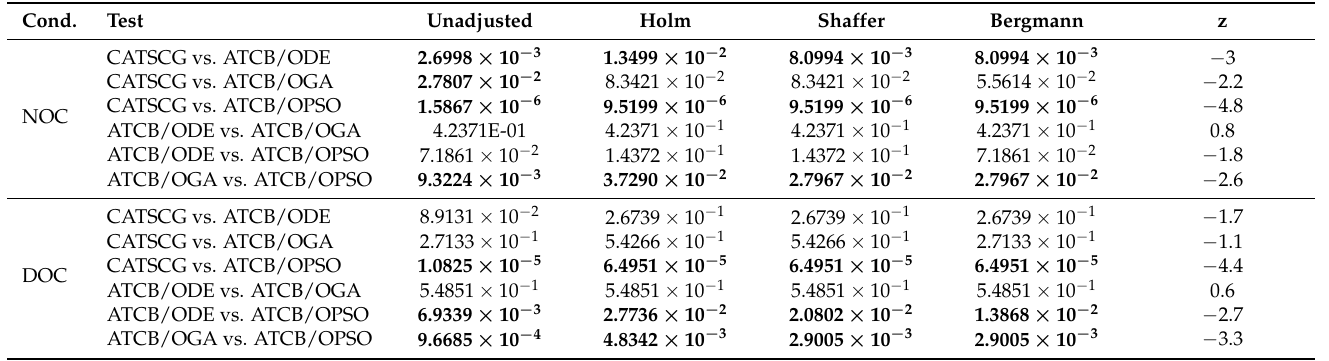
Table 8. Results of the post hoc Friedman test over the values of ISE for the adaptive controller tuning. Cond.